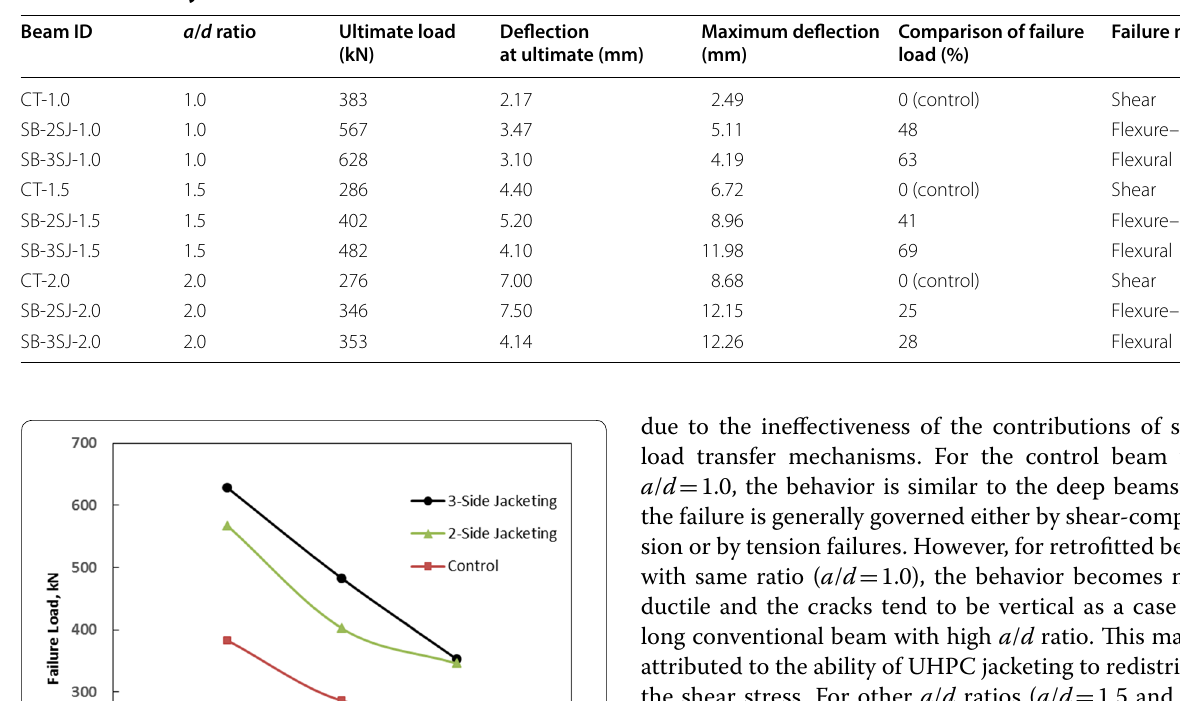
Table 7 Summary of the results of tested beams.